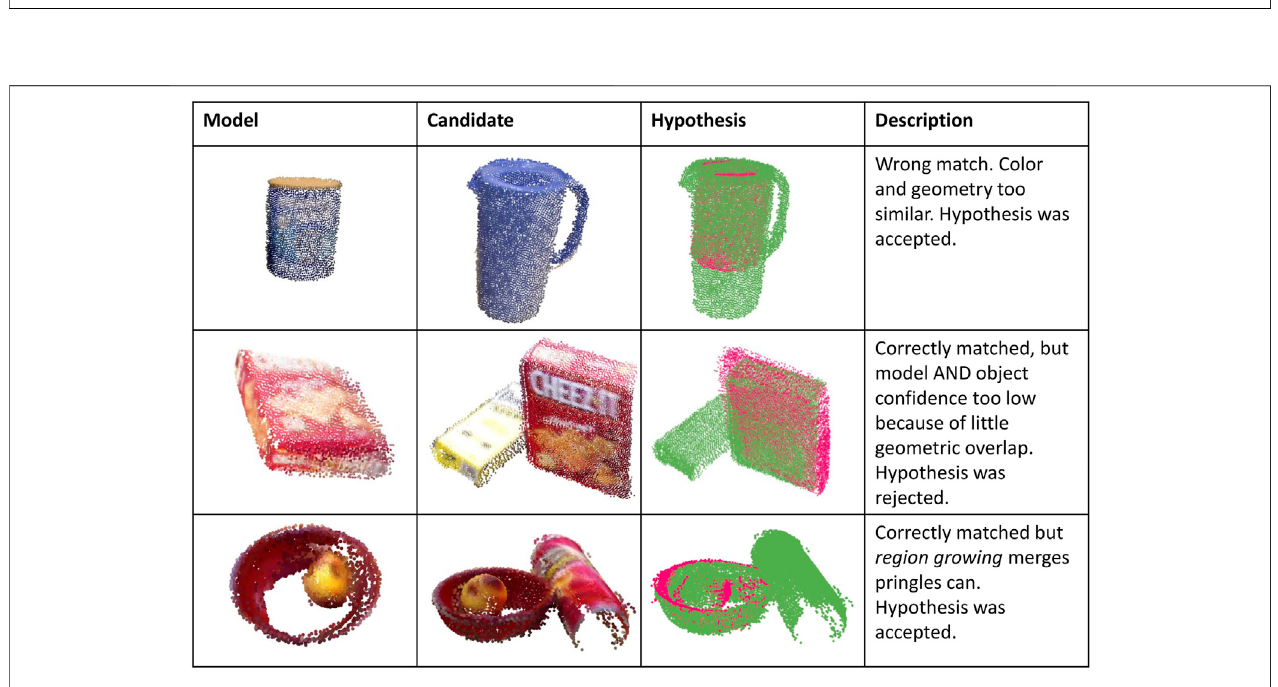
FIGURE8| Examplesofmissedobjects.Extractedplanesarevisualizedinred.Firstimage:twoobjectsinblackrectangle.Onlytheyellowcupisdetectedbecause the couch seat is too curved. Second and third image: only few object points are within the convex hull of the plane and therefore classi fi ed as noise and rejected. Note, that in the third example the reconstruction is very sparse because the robot did not get close enough to the surface.